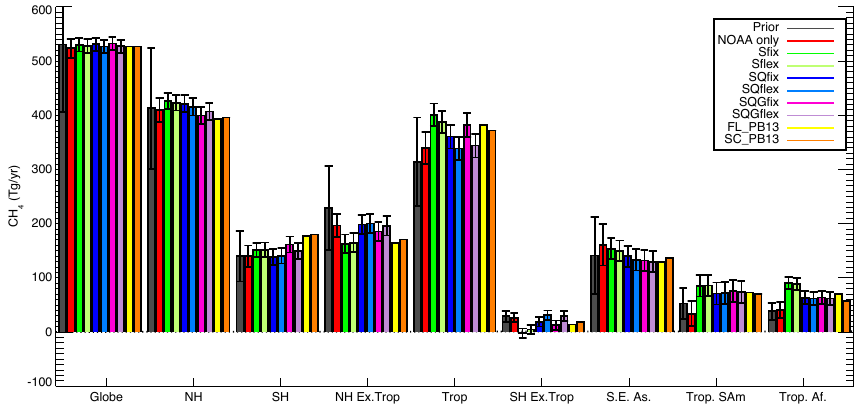
Fig. 15. As Fig. 14 with fluxes representing the difference between 2years preceding and following July 2006. The uncertainties for the two time intervals are assumed Fig. 14. Comparison of inversion derived fl uxes integrated over regions and over the period 2003–2010, including results from the NOAA- only (S1-NOAA) and NOAA+SCIA (S1-SCIA) inversion from Bergamaschi et al. (2013). Error bars represent 2 σ uncertainties. For the region de fi nition see Figure 1.